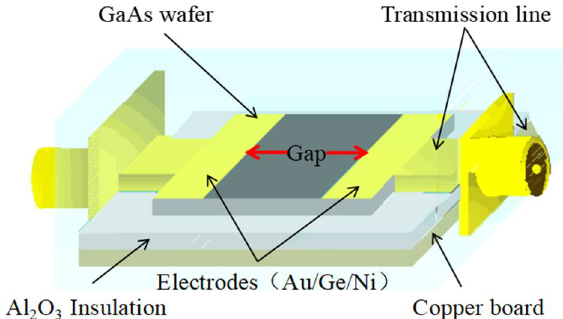
Figure 1. High-avalanche SI-GaAs PCSS structure.